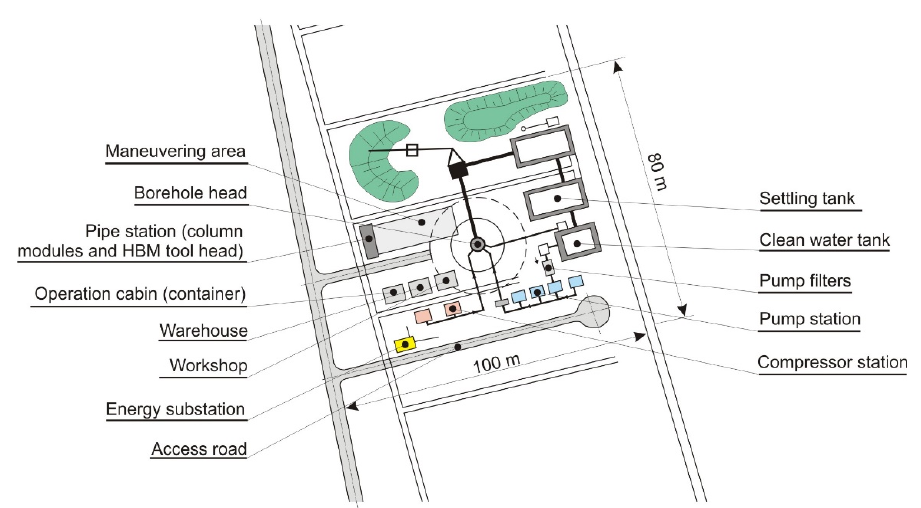
Figure 6. A site development plan around the HBM production borehole. The required minimum area around the production borehole should be approximately (8000 m 2 )